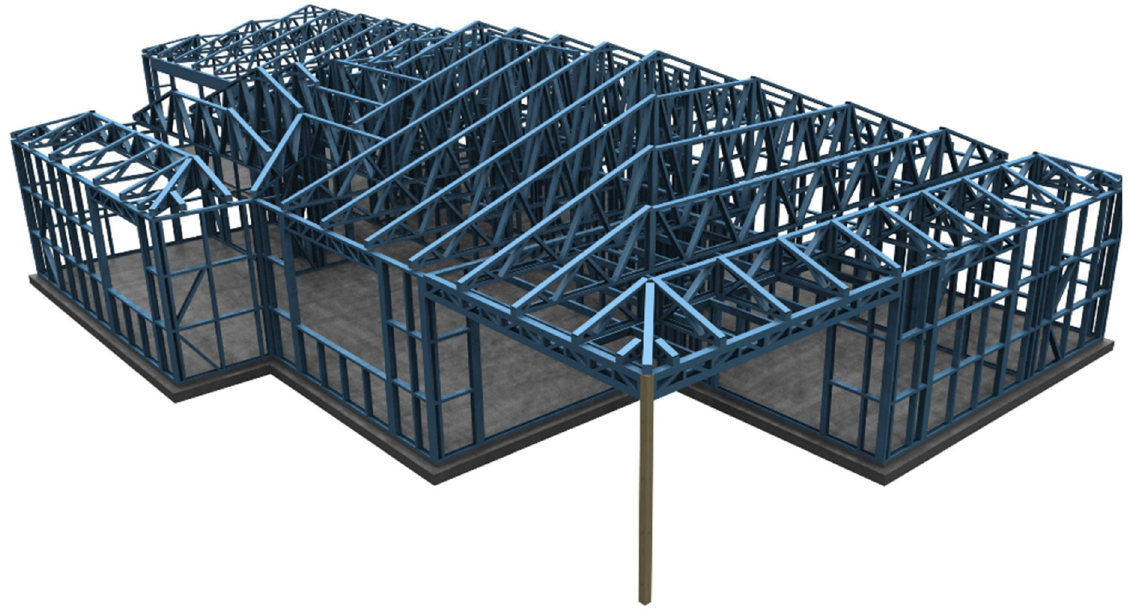
Figure 1. The selected steel-framed detached house in Palmerston North, NZ.